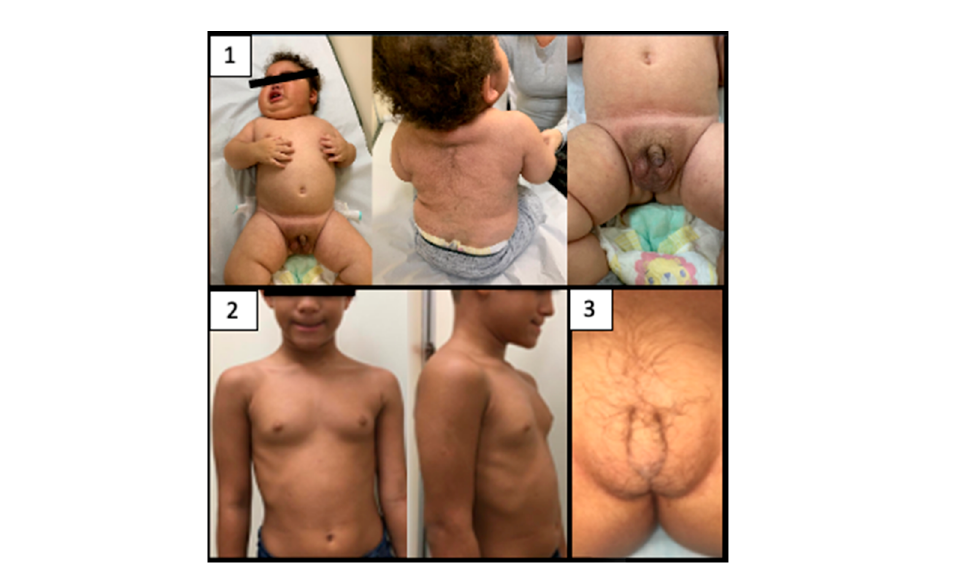
Figure 2. Clinical manifestations of patients with PACTs. 1: male patient (9 months of age) with mixed syndrome (VS and CS); 2: Male patient (5 years of age) with estrogen, androgen and cortisol producing tumor (gynecomastia and an important bone age advance); 3: Female patient (1 year of age) with pubic hair and clitoromegaly (2.7 cm). The parents gave a written informed consent for the publication of the images. Table 2. Hormonal data of patients with PACTs from three